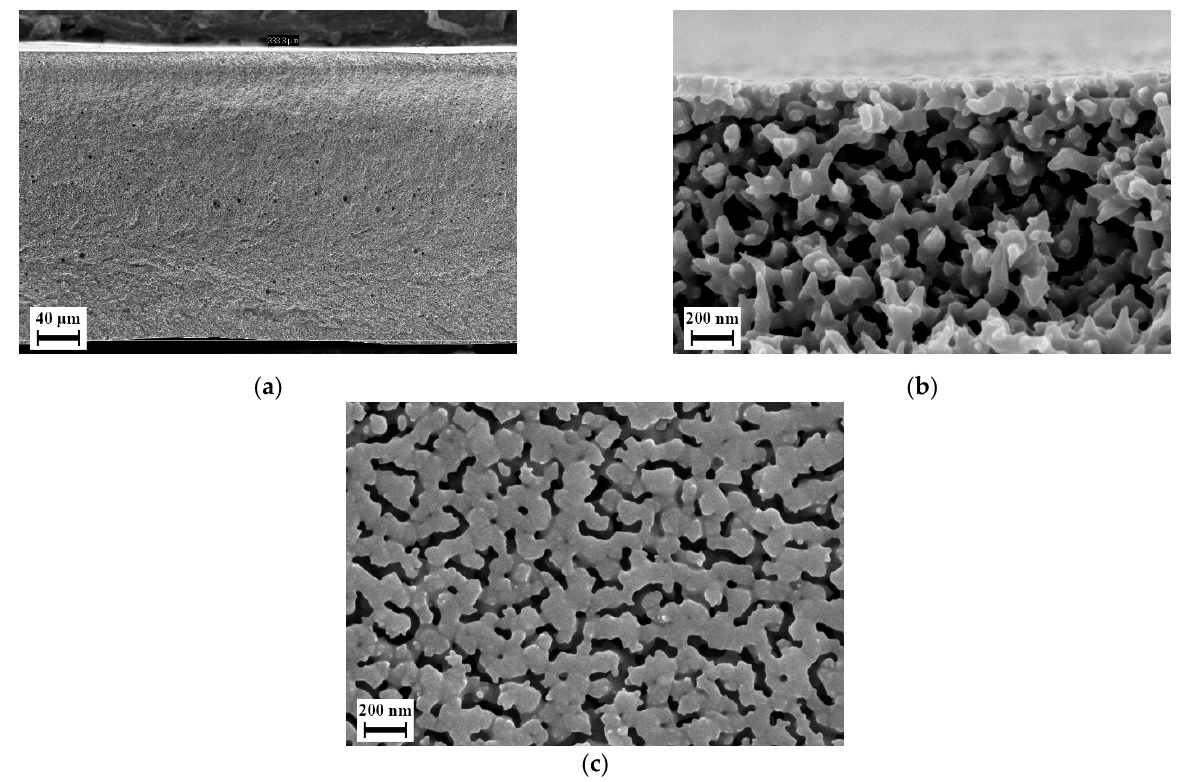
Figure 12. Scanning electron micrographs of sandwich-type sample manufactured using method II with blend H-32, after batch foaming and post-treatment: ( a ) cross section; ( b ) internal structure; ( c ) surface.